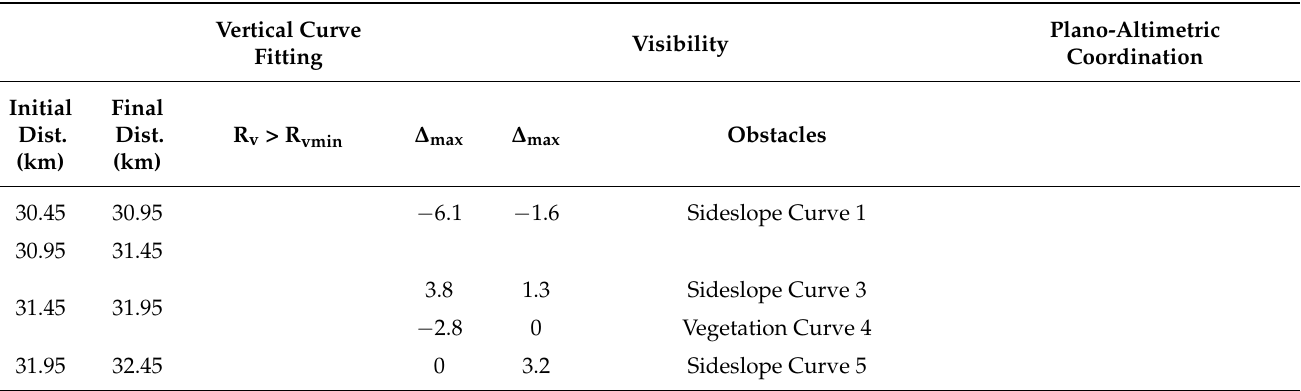
Table 3. Geometric verifications related to the road under-study-Vertical